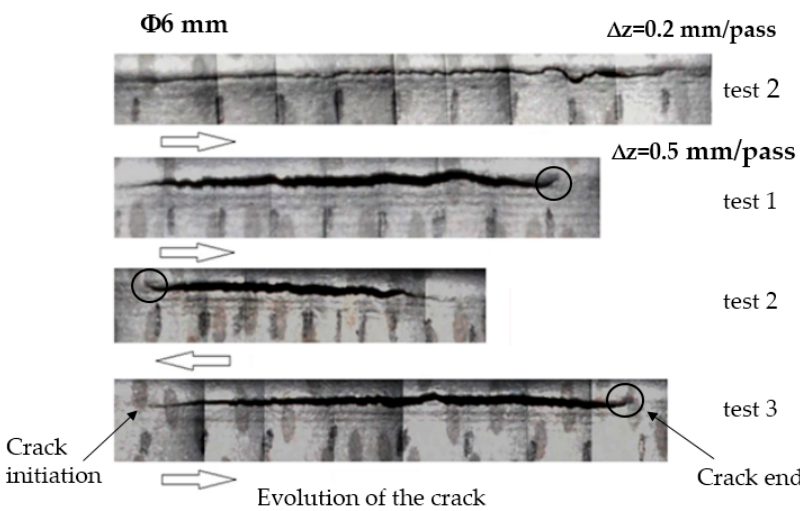
Figure 9. Evolution of the crack on the final testing part deformed by SPIF using a tool of Φ 6 mm diameter for some representative tests marked in bold in Table 2.